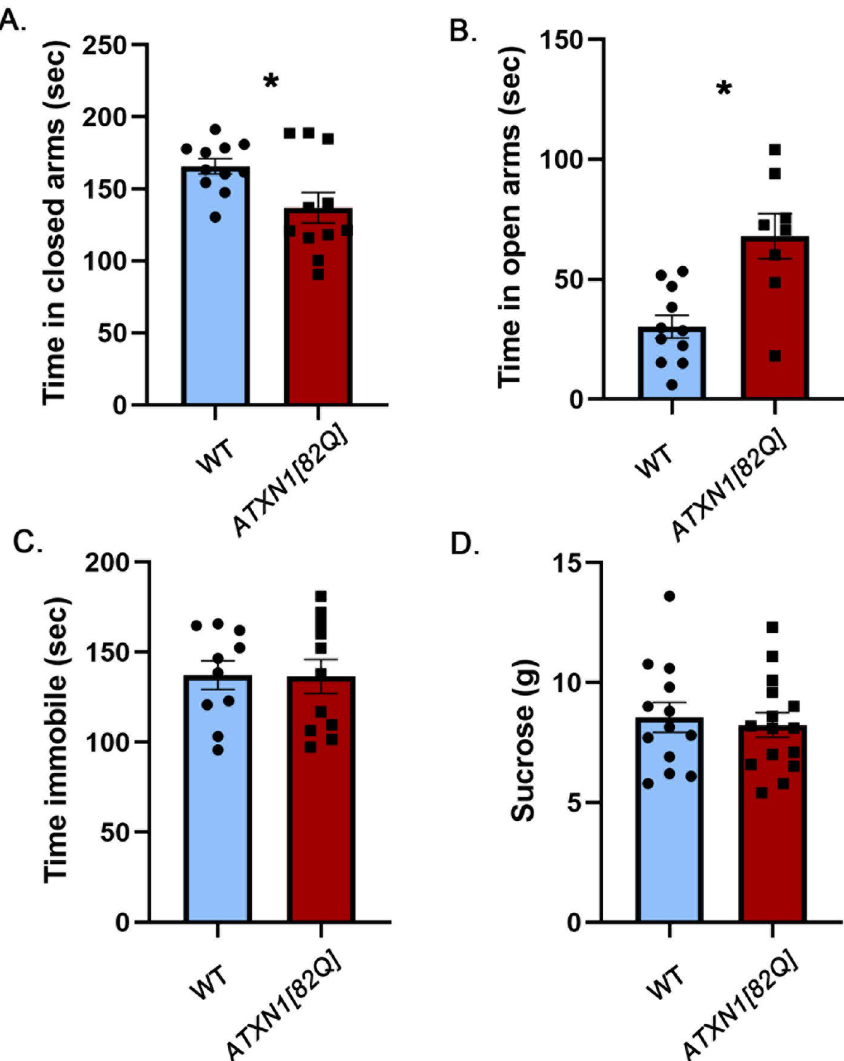
Figure 3. Cerebellar Purkinje cell-specific ATXN1[82Q] transgenic mice have attenuated anxiety. 8–10 weeks old ATXN1[82] mice and their wild-type littermates were tested on the Elevated Plus Maze, Forced Swim Test and Sucrose preference test. ( A ) Time in closed arms. ( B ) Time in open arms. ( C ) Time spent immobile. ( D ) Amount of sucrose consumed. * indicates P < 0.05 using the unpaired, two-tailed t test, data are presented as mean ±